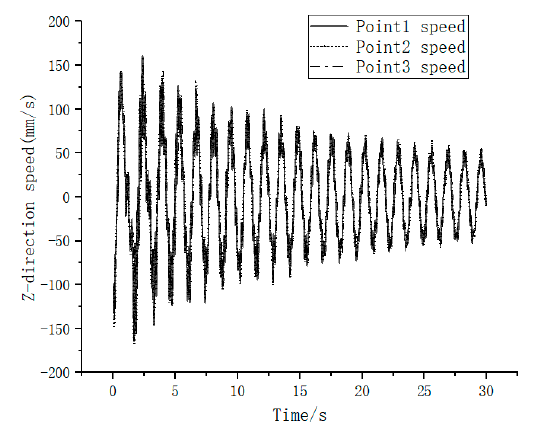
Figure 12. Measurement points Z-directional position versus time.